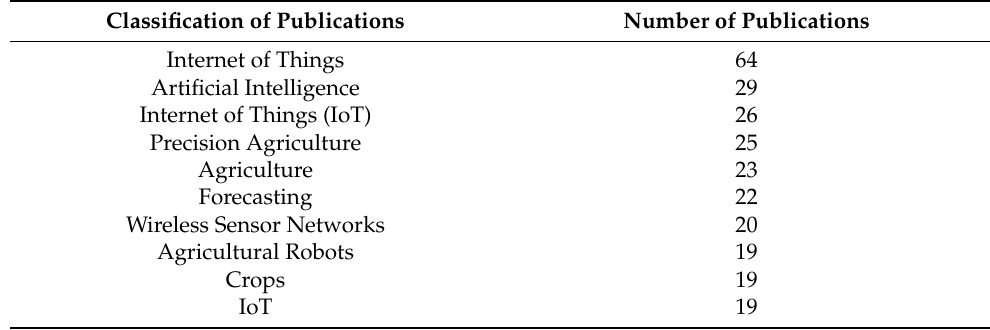
Table 5. Top ten keywords for IoT in plant disease